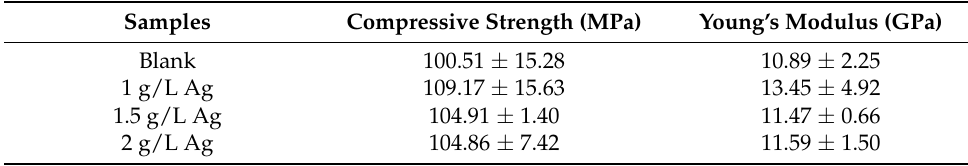
Table 1. Mechanical properties of the PEO-treated and -untreated